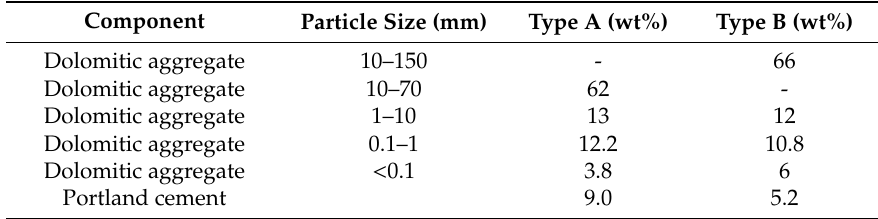
Table 1. Composition of type A and type B concrete [26].